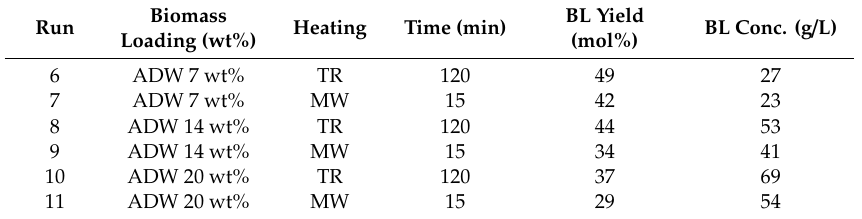
Table 2. One-pot butanolysis of the ADW Eucalyptus nitens to BL, with di ff erent biomass loadings (7,